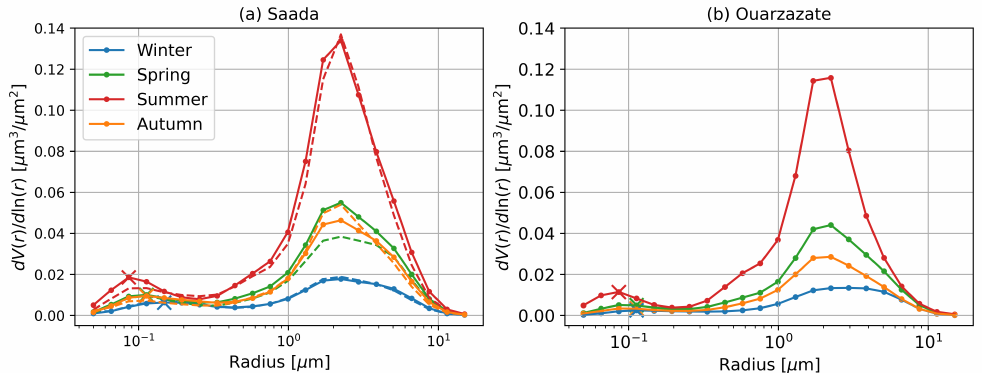
Figure 4. Seasonal volumetric size distributions of aerosols for ( a ) Saada (2004–2020) and ( b ) Ouarza- zate (2012–2015) averaged over winter (DJF), spring (MAM), summer (JJA) and autumn (SON). The dashed lines represent Saada’s seasonal aerosol volumetric size distribution from 10 February 2012 to 28 June